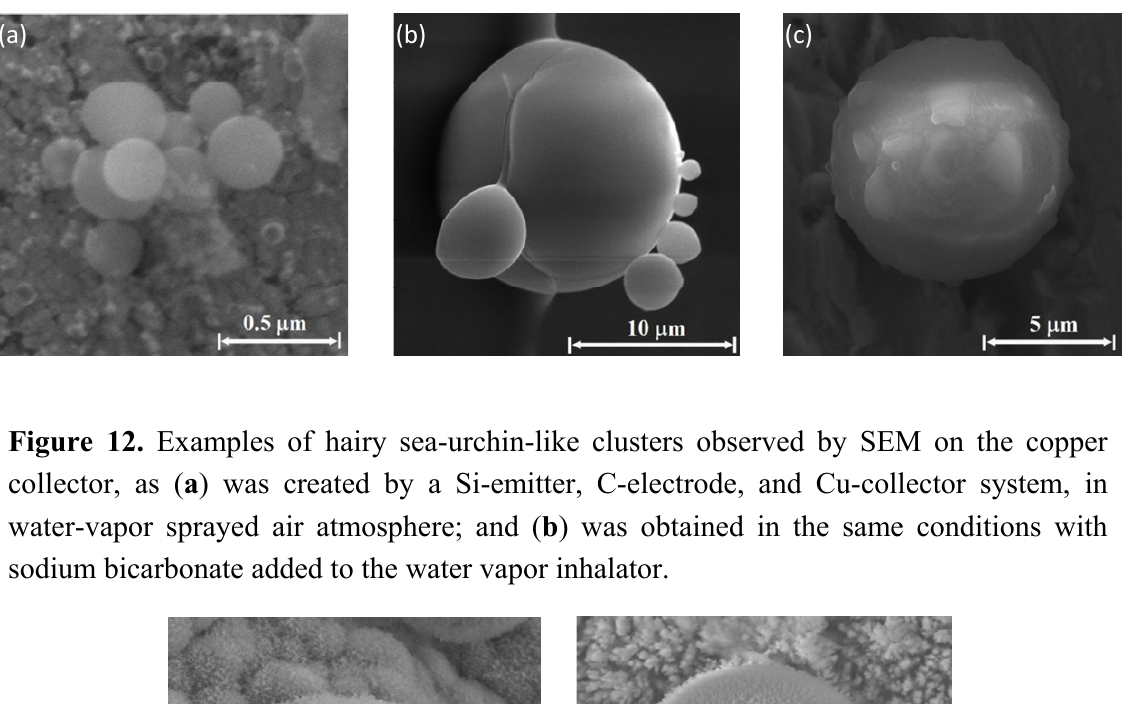
Figure 11. The particles presented were created by a Si-emitter, C-electrode, and Cu-collector system, in water-vapor sprayed air atmosphere: ( a ) examples of micro-particle clusters observed by SEM on the silicon emitter; ( b ) a micro-particle cluster observed by SEM on the silicon emitter; and ( c ) around sphere obtained in the same conditions with sodium bicarbonate added to the water vapor inhalator.